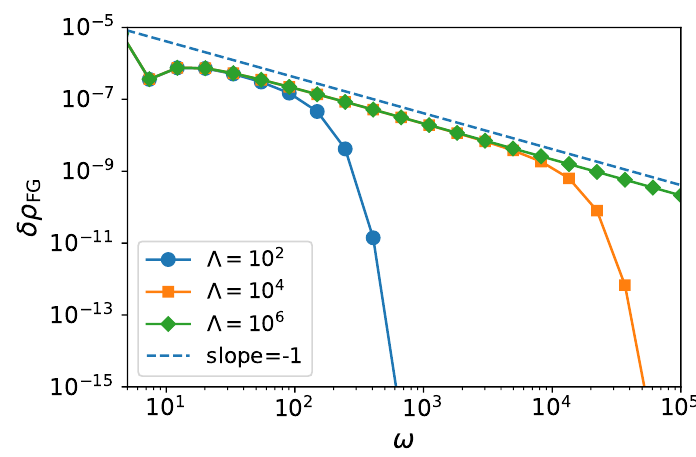
Figure 10: Difference between the FGS (93) and the exact NESS (92) for bath spec- tral cutoff Λ = 10 2 (circle), 10 4 (square), and 10 6 (diamond). The dashed line is the guide to the eye showing the slope of − 1. The other parameters are chosen as = 0.3, N = 1, N = 0.05, B = 0.1, γ = 0.2, and β = B s z x y d 0